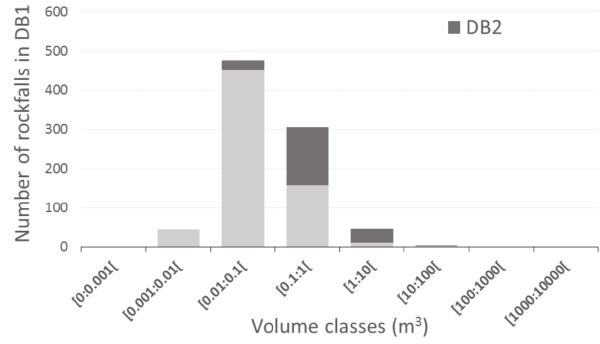
Figure 2. Volume distribution of the two